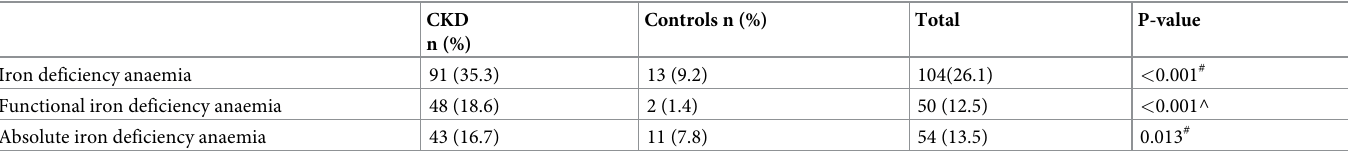
Table 2. Iron status in the study participants.